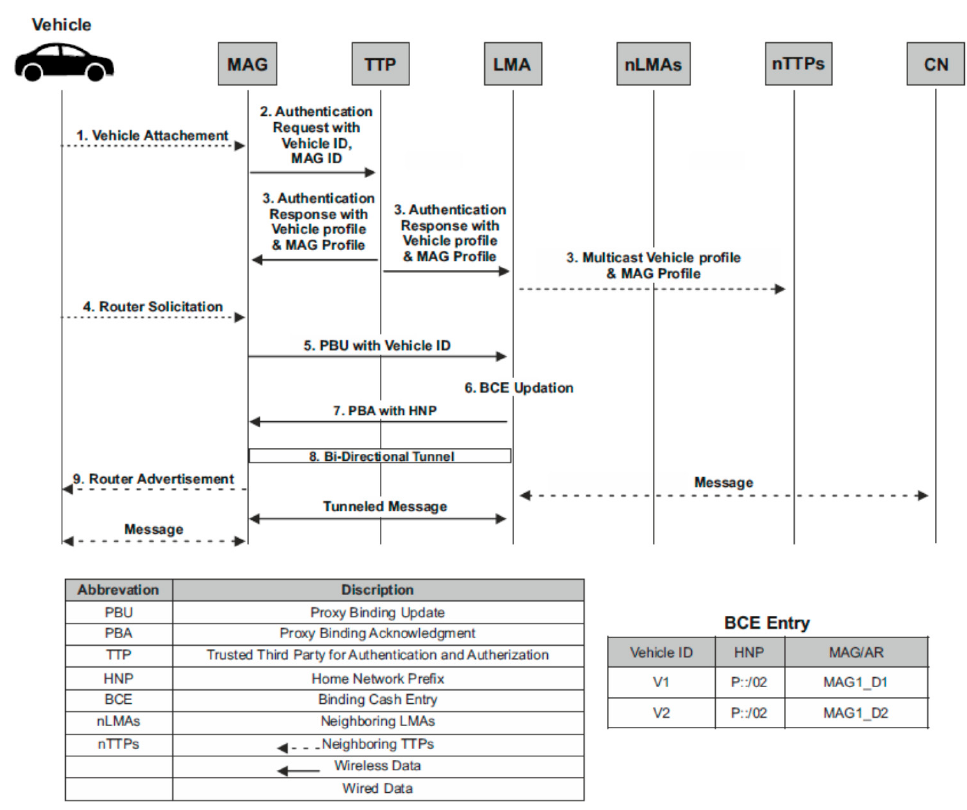
Figure 3. Sequence diagram when a vehicle connects to the PMIPv6 domain.